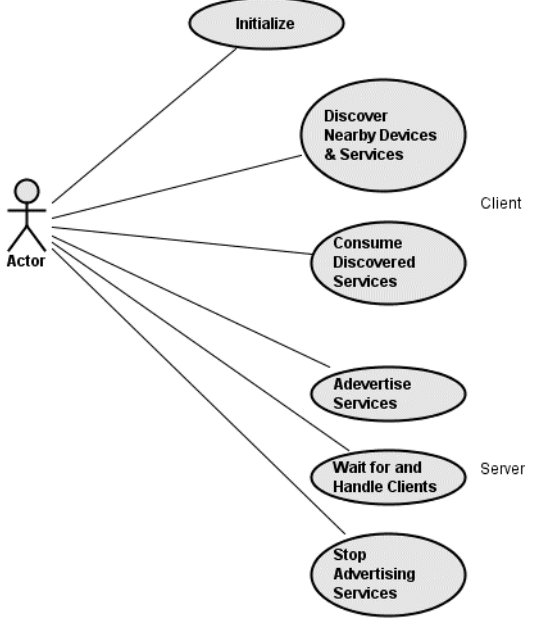
Figure 7. Bluetooth pairing